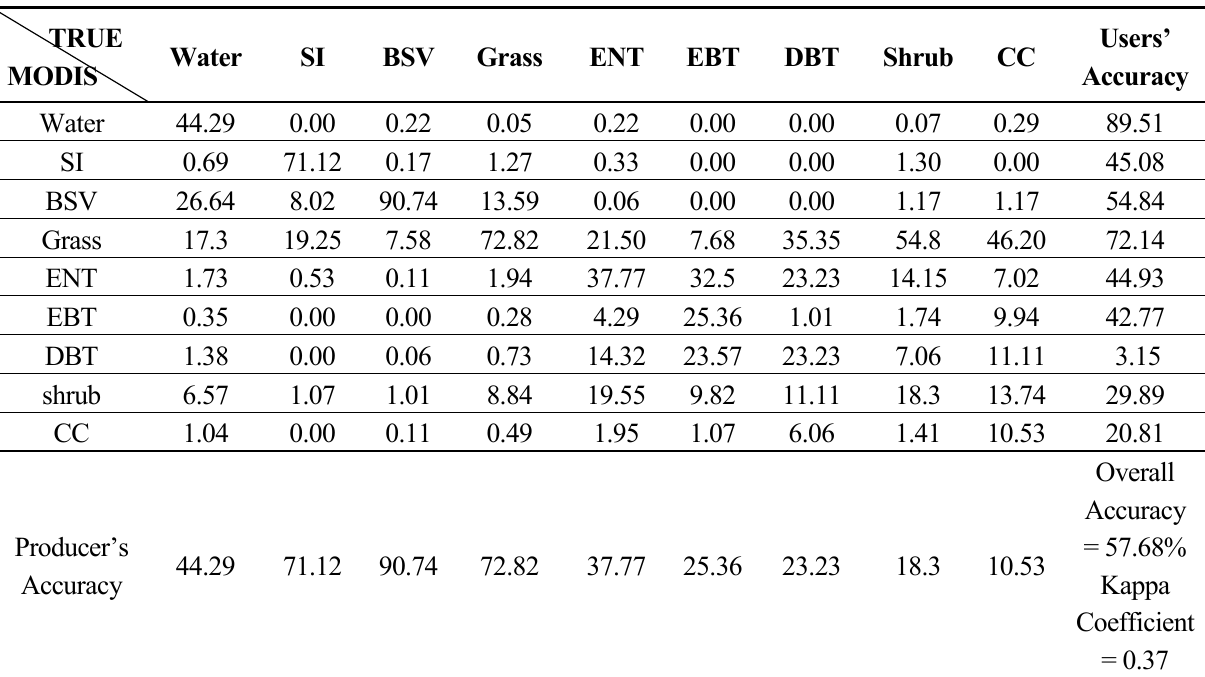
Table 2. Confusion matrix of MODIS 2007 PFT map (based on 13,081 reference points selected from Chinese Vegetation Map). For simplicity, vegetation types represented by initials in bracket: evergreen needle leaf trees (ENT), evergreen broad leaf trees (EBT), (CC), snow and ice (SI), barren or sparse vegetation (BSV).